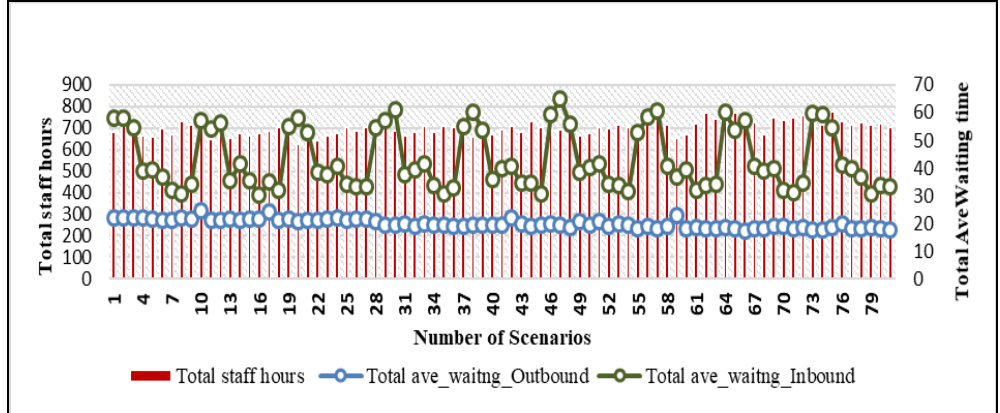
Figure 13. Dynamic resource allocation method results.